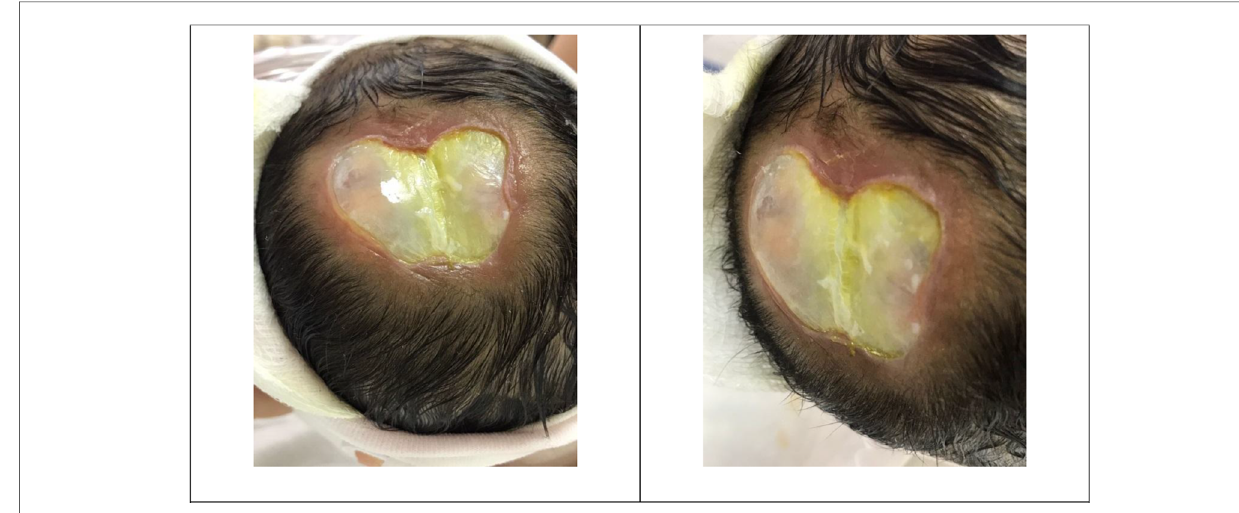
FIGURE 1 Patient ’ s skin defect. The newborn head showing a 6 by 5 cm full-thickness defect of the scalp, skull, and dura. An arachnoid layer covering the brain with noted brain tissue can be noticed. Also, the exposed superior sagittal sinus covered with a layer of granulation can be noticed.